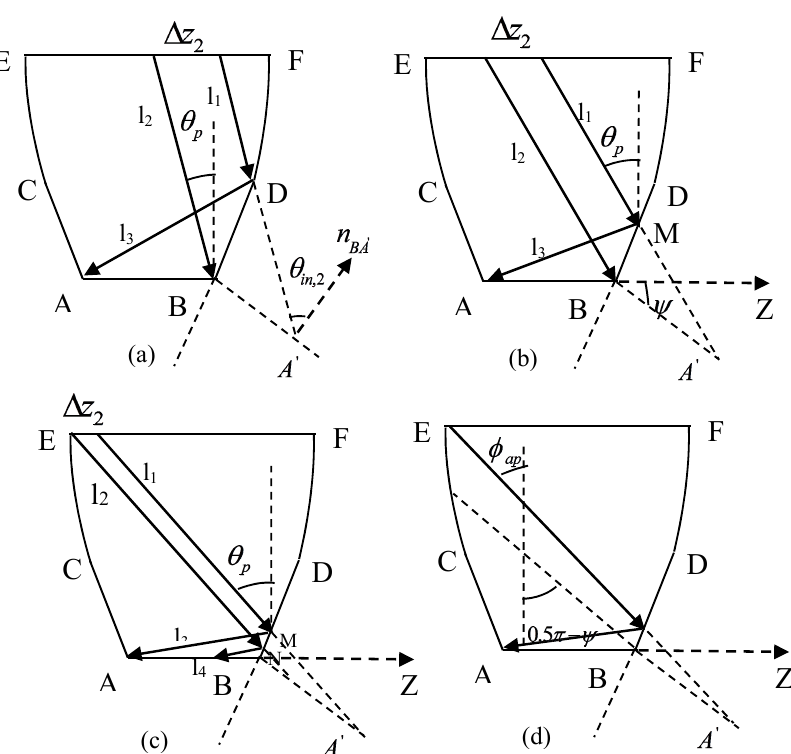
Figure 5. Fraction of refractive radiation incident on right plane wall and arriving on solar cells. ( a ):